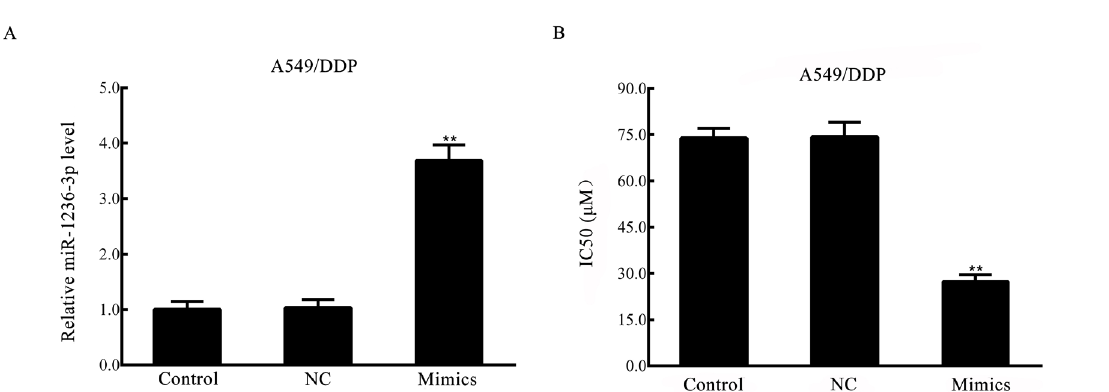
Figure 3: miR-1236-3p regulates the DDP resistance in lung cancer cells. (A) The transfection efficiency of miR-1236-3p was detected by RT-qPCR assay. (B) The IC50 values of DDP were analyzed by MTT assay. **P<0.01, mimics vs NC group. Control, un-treated cells; NC, miR- 1236-3p mimics negative control-transfected cells; miR-1236-3p, cells transfected with miR-1236-3p mimics group; A549, lung cancer cell line; A549/DDP, human lung adenocarcinoma drug-resistant cell line; IC50, the half maximal inhibitory concentration; miR,